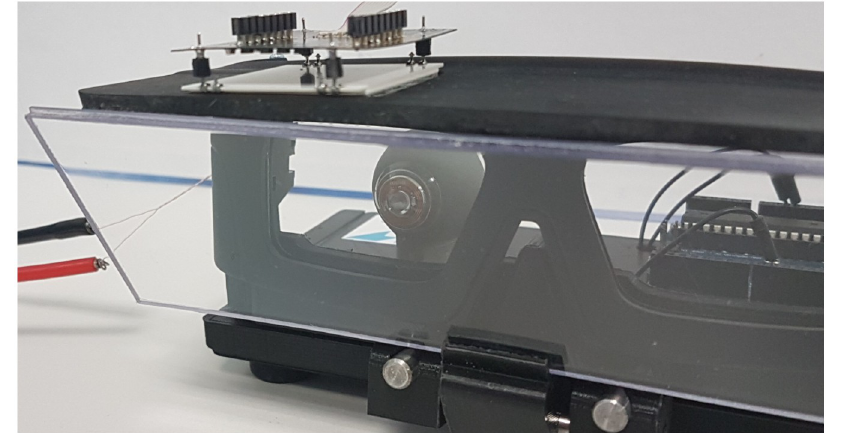
Fig 13. PSD compact eyewear. PSD is mounted on top of the